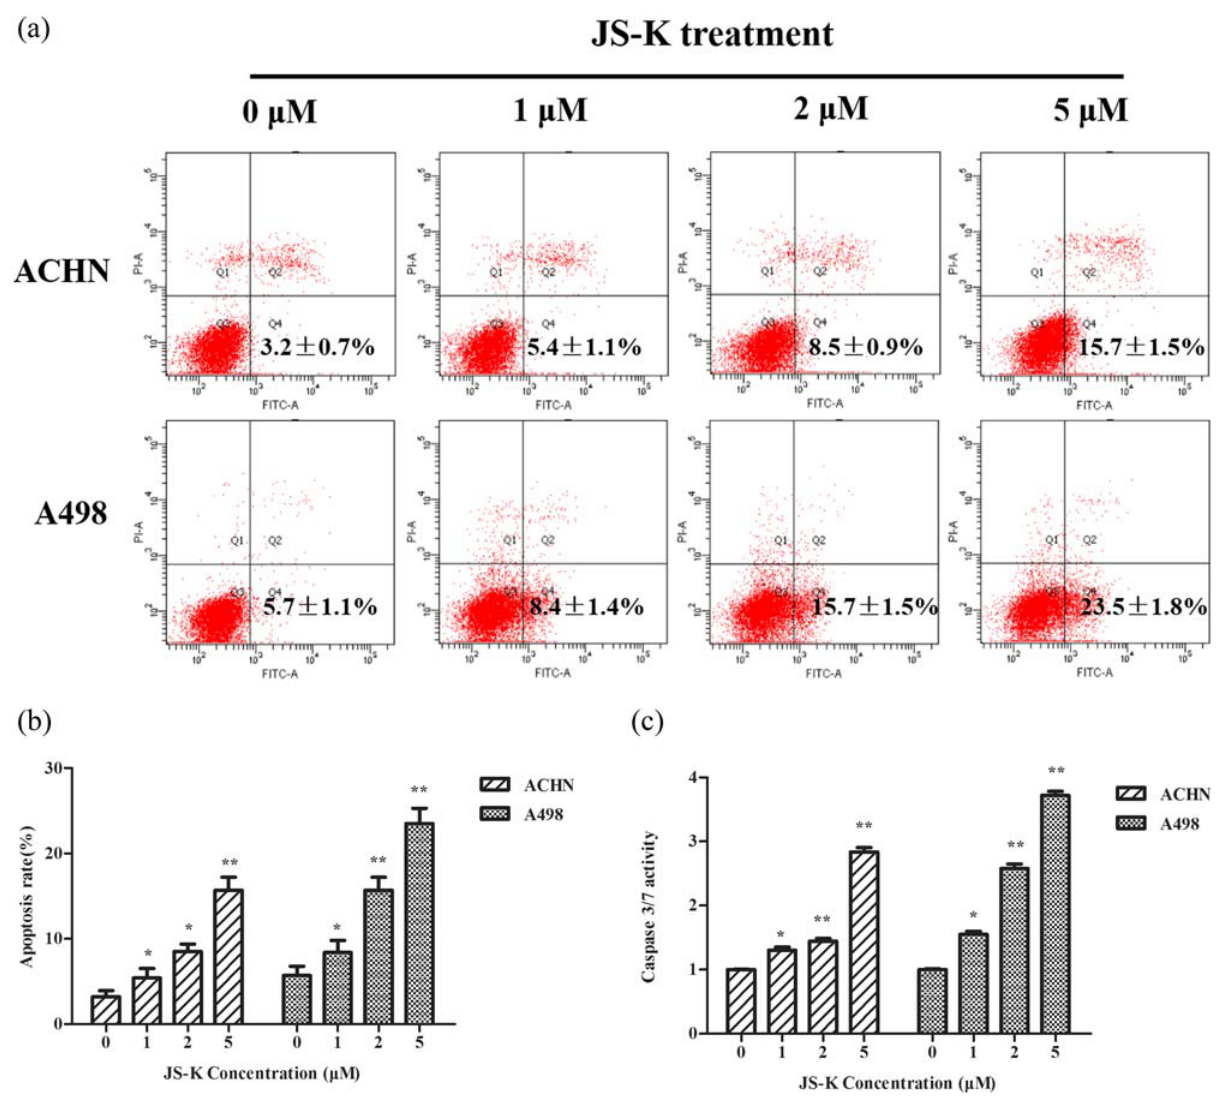
Figure 3: JS - K induces apoptosis in renal carcinoma cells. ( a and b ) JS - K - induced renal carcinoma cell apoptosis was analyzed by fl ow cytometry by using the staining method of Annexin V. Cells untreated were studied as controls. ( c ) Renal carcinoma cells were treated for 360 min with JS - K ( 0, 1, 2, and 5 μ M ) and then intracellular activity of caspase - 3/7 was detected. For at least three separate assays, fi ndings are reported as mean ± SD. Single asterisks ( * ) show a substantial di ff erence ( P < 0.05 ) , and double asterisks ( ** ) show a very important di ff erence ( P < 0.01 )